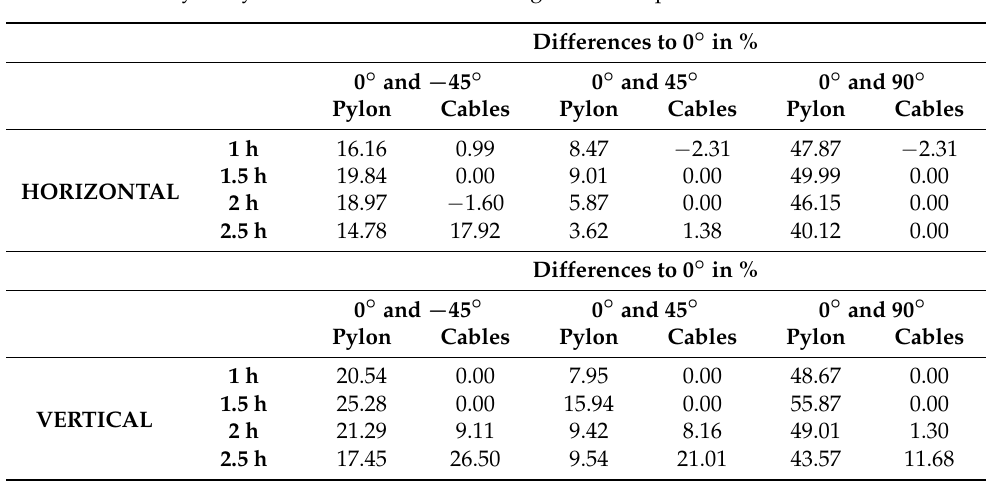
Table 7. Sensibility analysis of the influence of the angle to the 0 ◦ position.